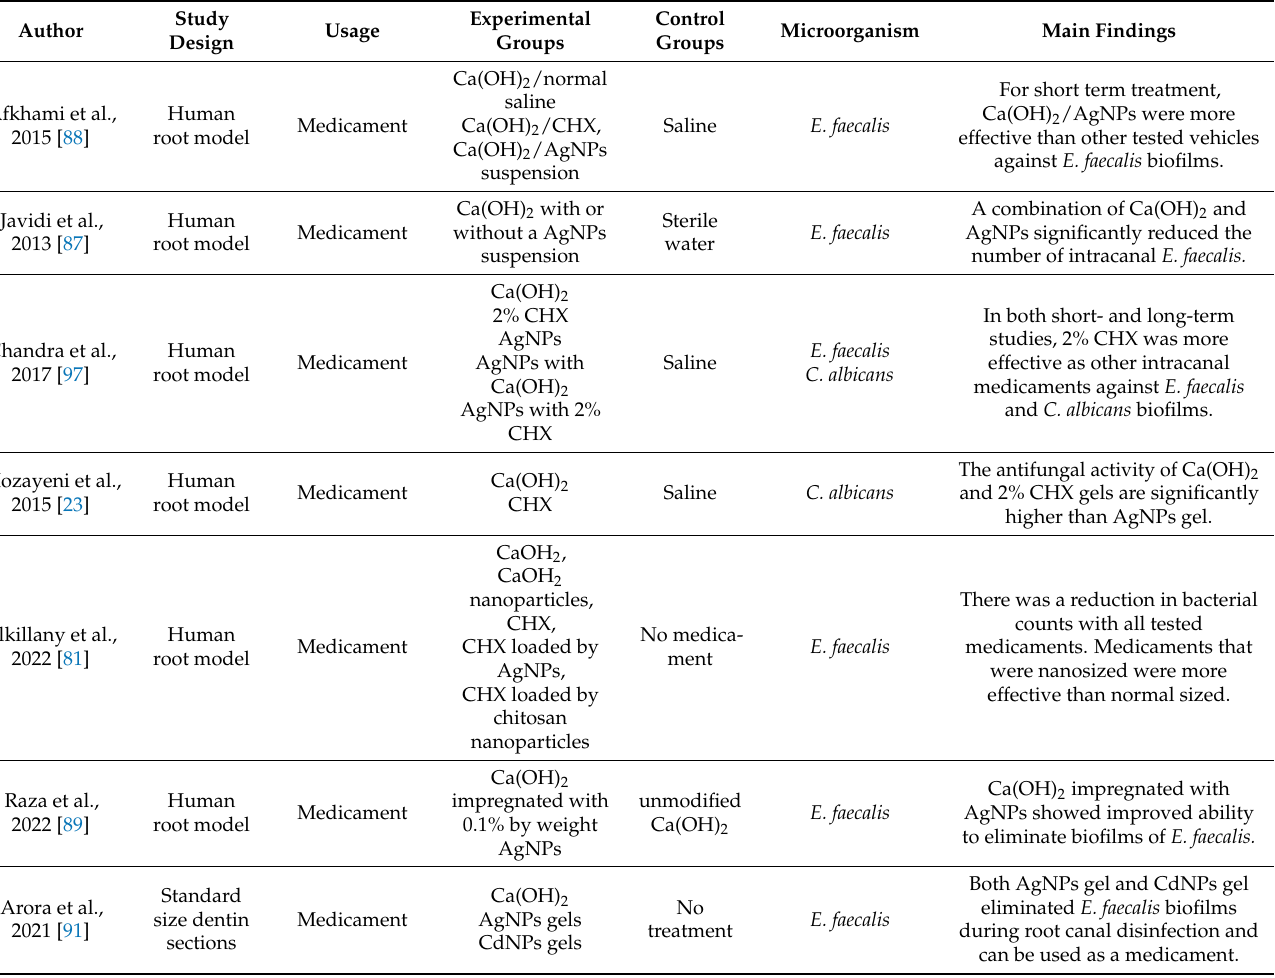
Table 3. Studies of alternative antimicrobial medicament highlighting antimicrobial type, study design, usage, experimental and control groups, microorganisms tested, and main